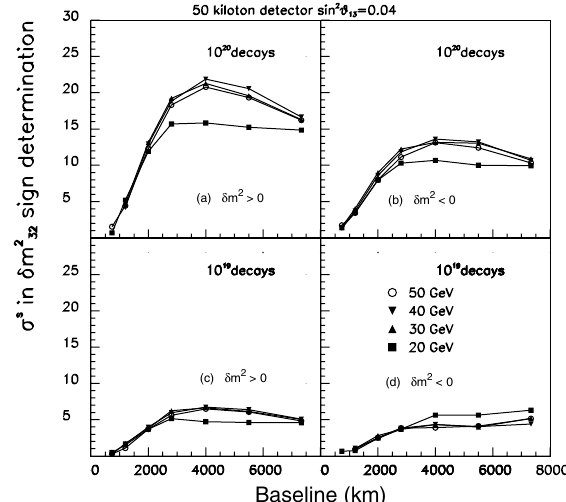
FIG. 5. The statistical significance (number of standard devi- can be determined versus ations) with which the sign of (cid:6)m 2 32 baseline length for various muon storage ring energies. The results are shown for a 50 kt detector, and (a) 10 20 (cid:3) (cid:2) and (cid:3) (cid:1) , (c) (cid:3) (cid:2) stored and decays and positive values of (cid:6)m 2 ; (b) 10 20 (cid:3) (cid:2) and (cid:3) (cid:1) decays 32 32 . The values of ; (c) 10 19 (cid:3) (cid:2) and (cid:3) (cid:1) decays and and negative values of (cid:6)m 2 32 32 ; (d) 10 19 (cid:3) (cid:2) and (cid:3) (cid:1) decays and positive values of (cid:6)m 2 32 negative values of (cid:6)m 2 32